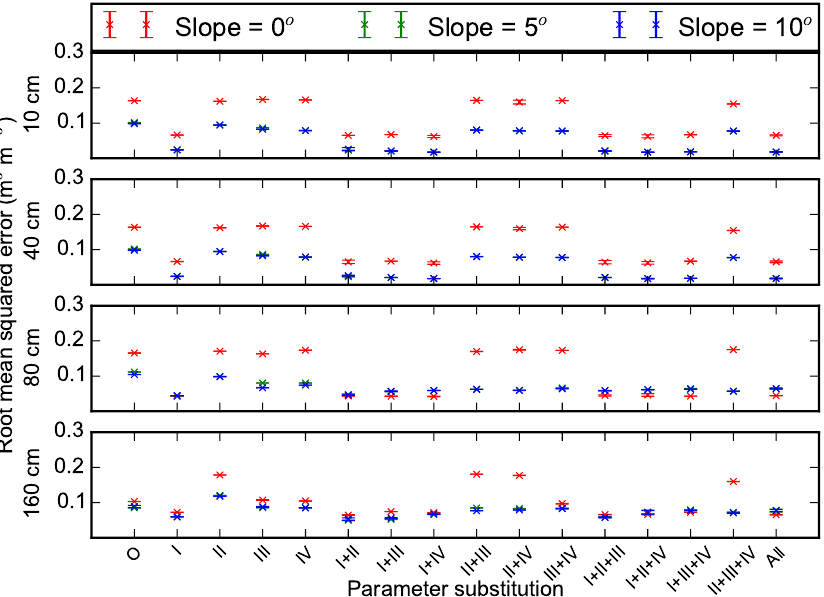
Figure 12. Root mean square errors between measurements and model simulations (with different combinations of measured porosity (I), thermal conductivity (II), hydraulic conductivity (III), and matric potential (IV) substituted for default loam parameters) for 10, 40, 80, and 160cm soil volumetric liquid water content. O and All represent model runs without substitution of default parameters and with all four parameters substituted. Mean and standard deviation of model simulations with three different soil thicknesses at each slope (0, 5, and 10 ◦ ) are